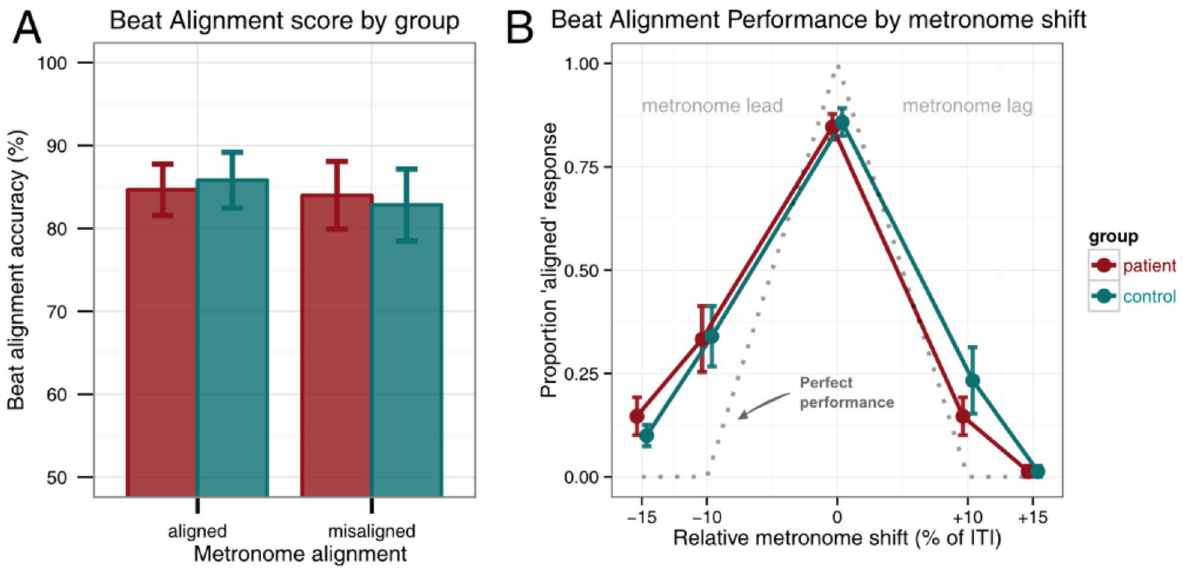
Figure 3. Beat alignment test results. (A) Overall accuracy scores. Error bars indicate standard error of the mean. (B) Aligned responses according to relative metronome shifts. Error bars indicate standard error of the mean.